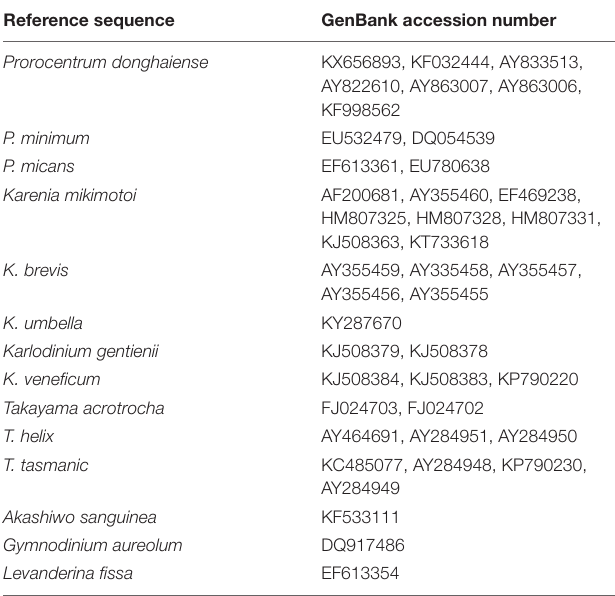
TABLE 2 | Representative species and accession numbers of their LSU rRNA gene sequences included in the